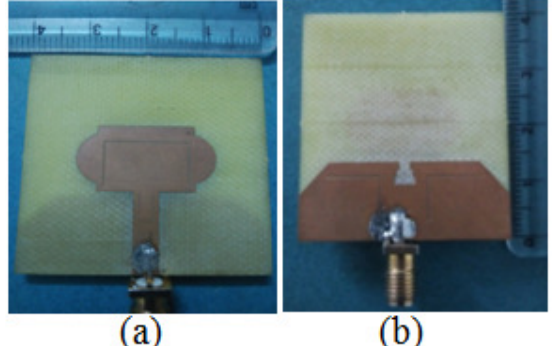
Figure 5: Proposed triple band notch hammer-shaped Antenna-D geometry (a) top side, and (b) bottom side.